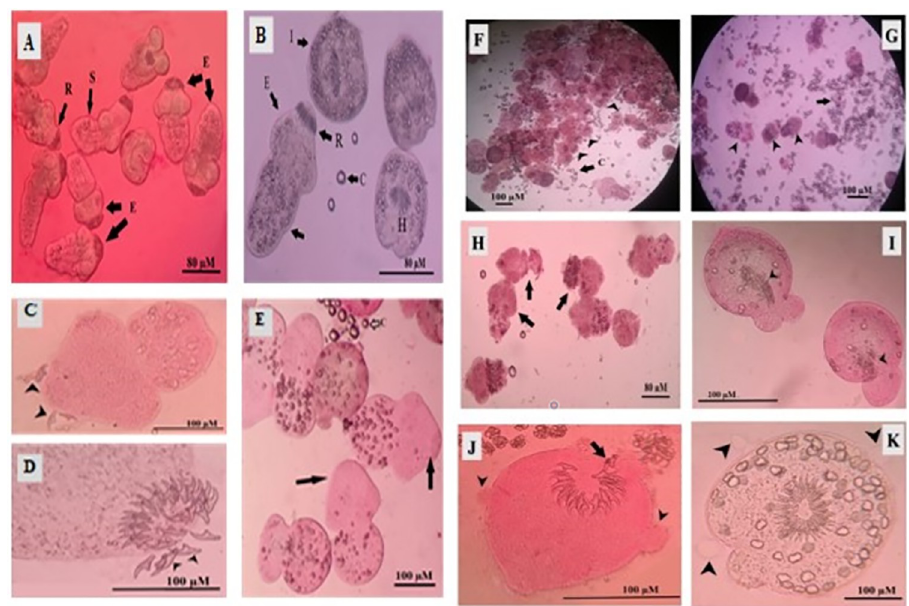
Fig 7. LM changes of PCs stained with 0.1% aqueous eosin stain after 24 h incubation with 0.2 μ l/ml Eug, Eug-NE and, ABZ. (A and B) Control PCs. (A) × 10 and (B) × 200. Red PCs are dead. (C–E) Dead PCs after incubation with Eug-NE. Note the disorganization of rostellar hooks (arrowheads). (C) × 400 and (D) × 1000. Distortion of the soma region with a complete loss of hooks (arrows). (E) × 200. (F–I) Dead PCs after incubation with Eug. (F) Note aggregation and adherence of PCs (arrowheads; × 60). (G) Distortion of protoscolicidal morphology (arrowheads) with leakage of their content (arrow; × 100). (H) Distortion of the soma region with a complete loss of hooks (arrows; × 100). (I) Disorganization of hooks (arrowheads; × 400). ( J and K) Altered PCs after incubation with ABZ. (J) Dead protoscolex with several blebs in the tegument (arrowheads) and disorganization of hooks (arrow; × 400). (K) Viable protoscolex with several blebs in the tegument (arrowheads; ×